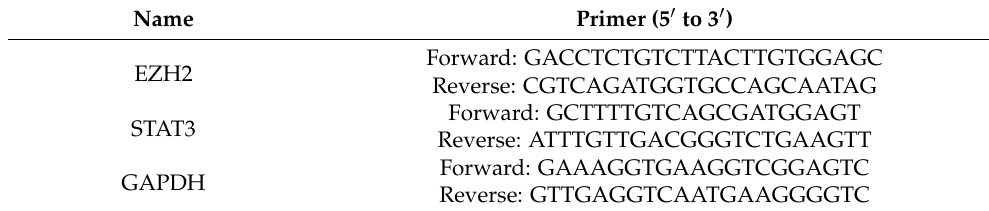
Table 1. Primer sequences used for RT-qPCR in this